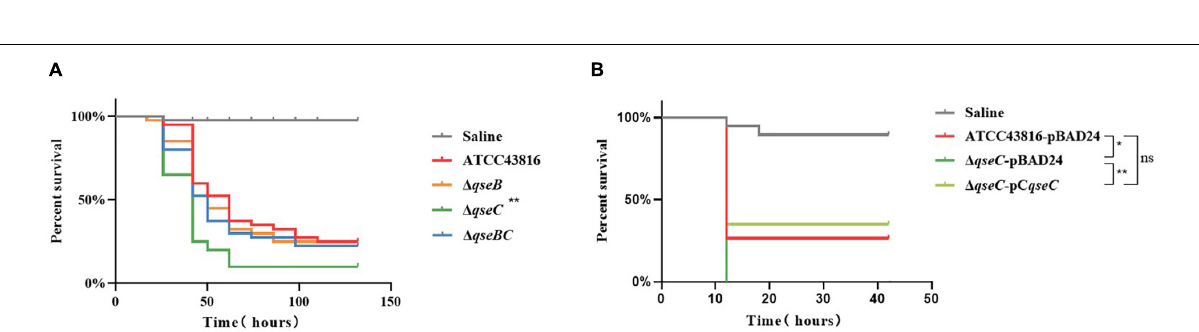
FIGURE 3 | (A) Effect of human serum on ATCC43816, (cid:49) qseB , (cid:49) qseC and (cid:49) qseBC . The bacteria were mixed with serum from healthy human volunteers for 2 hours. (cid:49) qseC had significantly higher resistance when compared to control ATCC43816 ( P = 0.0438, two tailed unpaired t test). (B) Effect of human serum on ATCC43816-pBAD24, (cid:49) qseC -pBAD24 and the complement strain (cid:49) qseC -pC qseC . (cid:49) qseC -pBAD24 had significantly higher resistance when compared to control ATCC43816-pBAD24 ( P = 0.0327, two tailed unpaired t test).